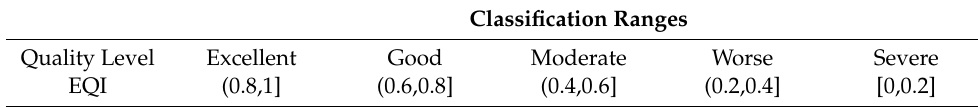
Table 4. Classification ranges of EQI.